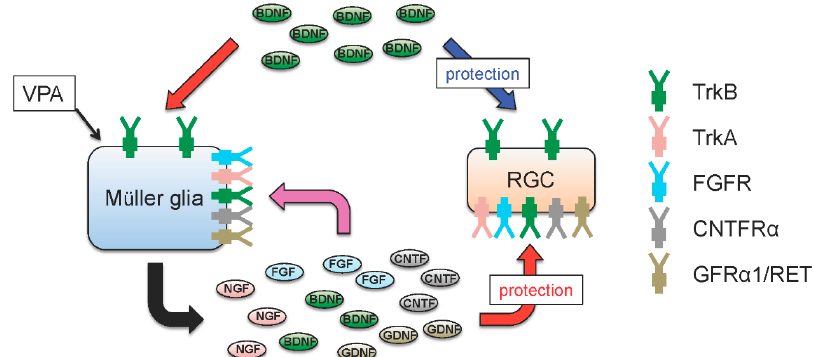
Figure 3. A schematic diagram of the retina with cell type-specific deletion of TrkB. In the TrkB GFAP KO retina, TrkB from Müller glia are selectively deleted. In the TrkB c − kit KO mice, TrkB from retinal ganglion cells and amacrine cells are selectively deleted. WT, wild-type.